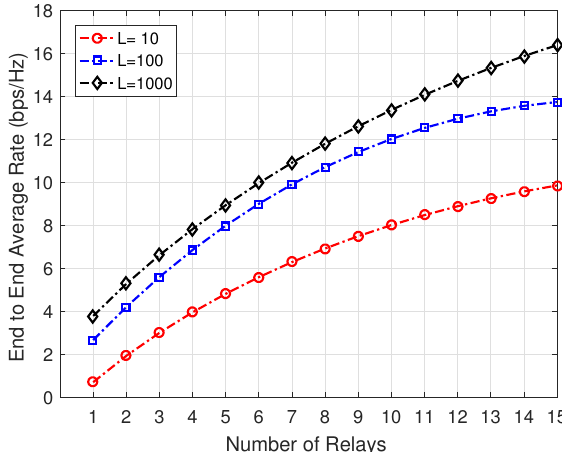
Figure 12. End-to-end rate vs. the number of relays.